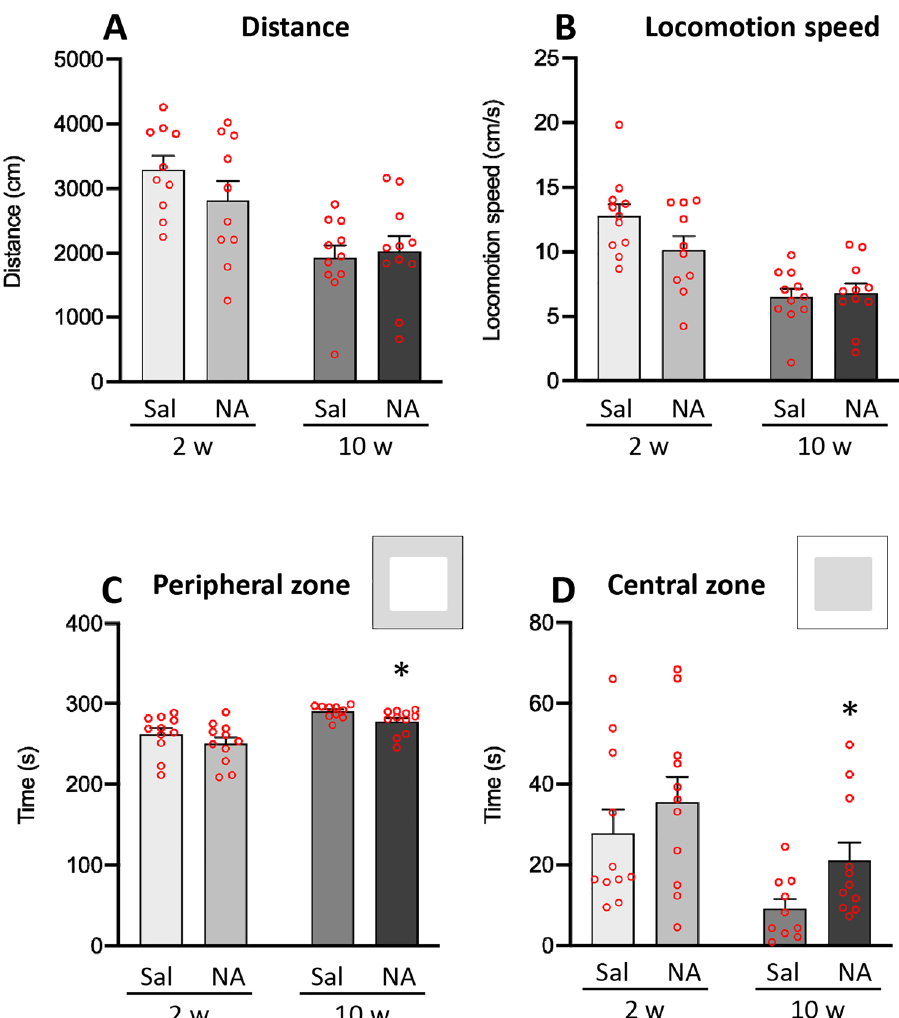
Figure 2. Parameters related to the locomotor capacity and area preference in the open field test. Animals were ICV-injected either with saline (Sal) or with neuraminidase (NA), and subjected to the open field test 2 weeks (2w) or 10 weeks (10w) after the ICV injection. The mean values ± SEM (n = 11 for both NA and Sal) of the distance travelled by the animals ( A ), the locomotion speed ( B ), the time spent in the peripheral zone ( C ) and the time spent in the central zone ( D ) are represented in histograms. Student’s t-test was performed in order to check the influence of treatment (Sal versus NA) at both assessments. * p <